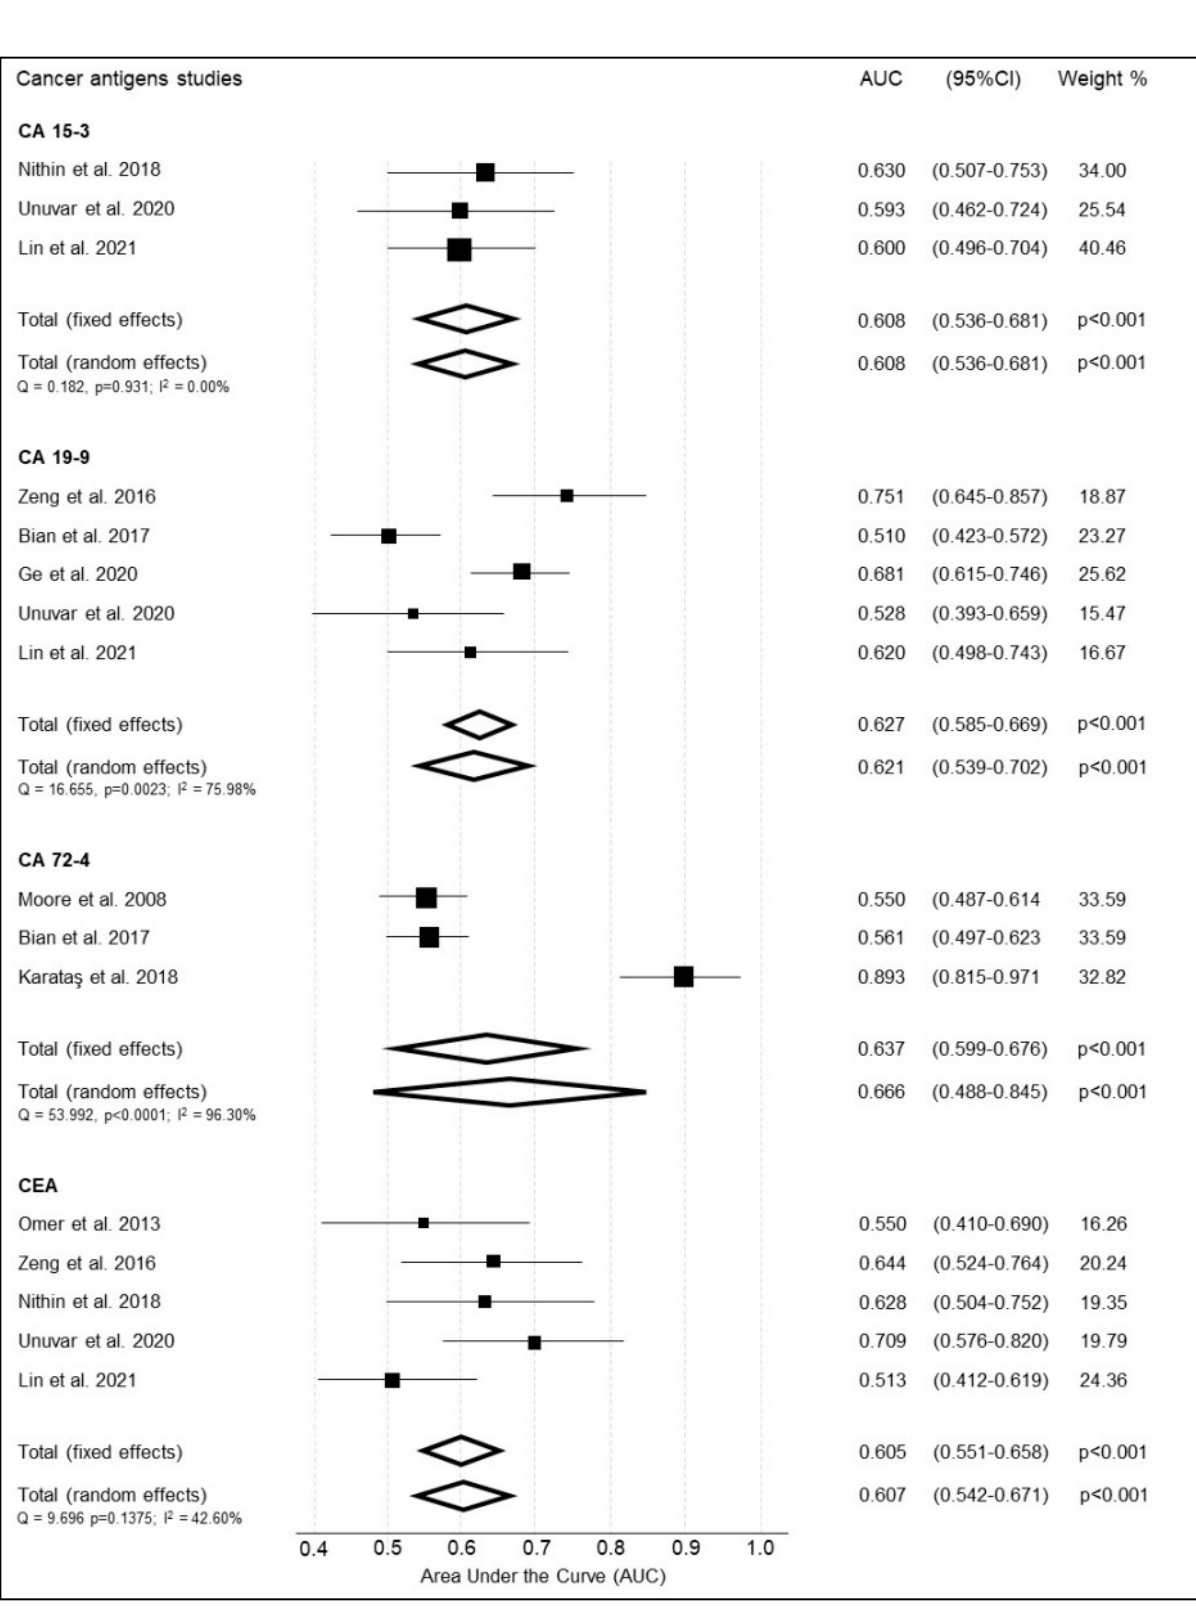
Figure 6. Summary of the diagnostic accuracy of proteomic cancer antigens included in the meta- analysis.